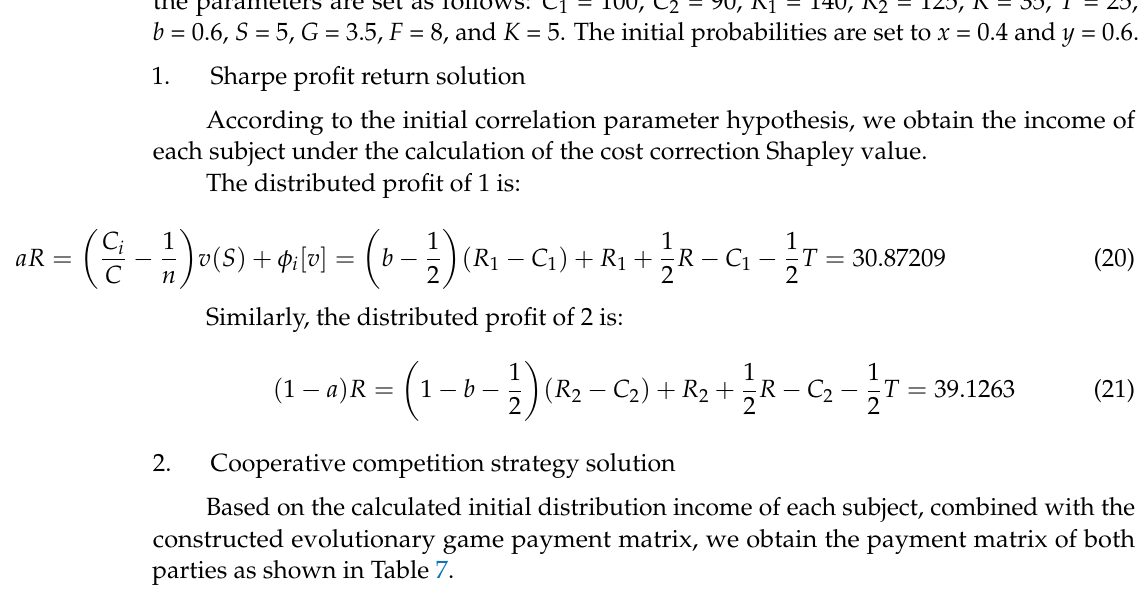
Table 7. Simulation analysis of the payment matrix of power grid enterprises and third-party enterprises. Evolutionary Game